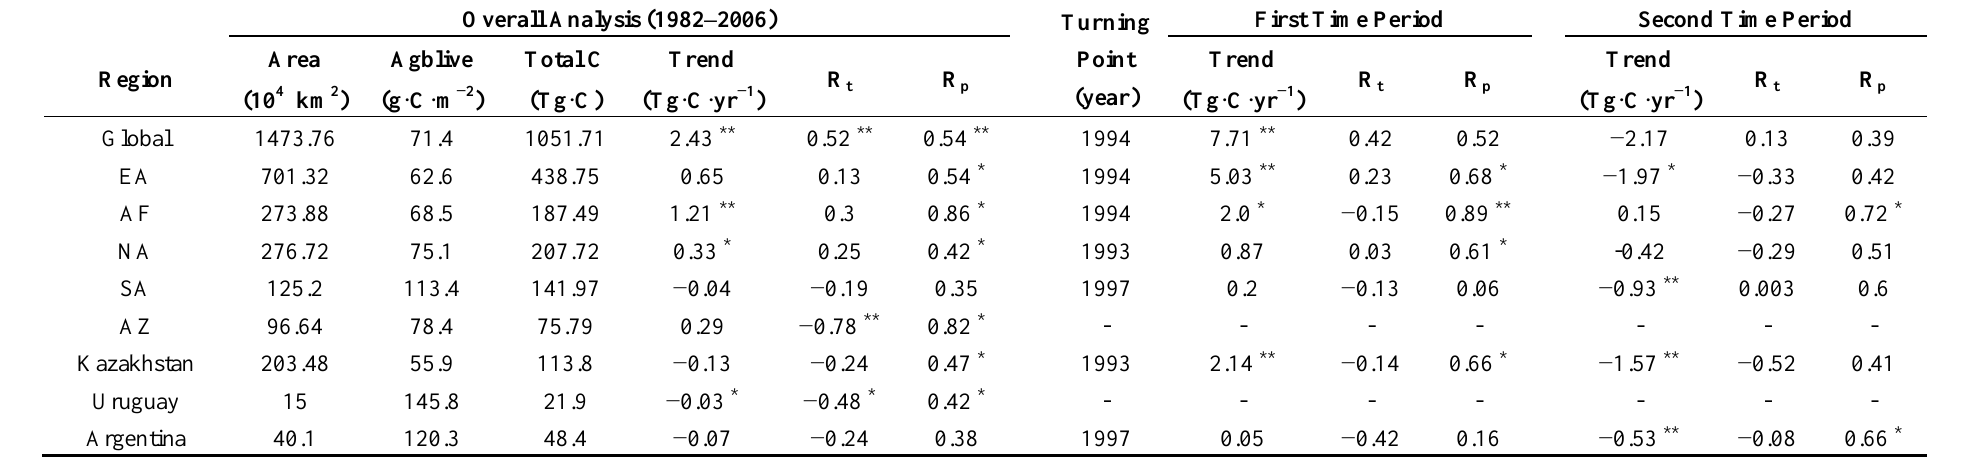
Table 1. Grassland area, mean aboveground live biomass carbon density (Agblive, g·C·m −2 ), total C stock (1 Tg·C = 10 12 g·C), linear trends (Tg·C·yr −1 ), and Pearson’s correlation coefficients of aboveground live biomass carbon from 1982 to 2006. Analysis of trends and correlations were performed for the entire period and by time segment. Turning point signifies a sudden change in trend between two time periods. R and R are the Pearson’s correlation coefficients between temperature and total C, and precipitation and total C, respectively. First t p and second time period refers to the time period before and after the turning point, respectively. As examples, the negative trends found in three countries ( i.e. , Argentina, Kazakhstan and Uruguay) are listed in the table, and their possible driving forces are described in the